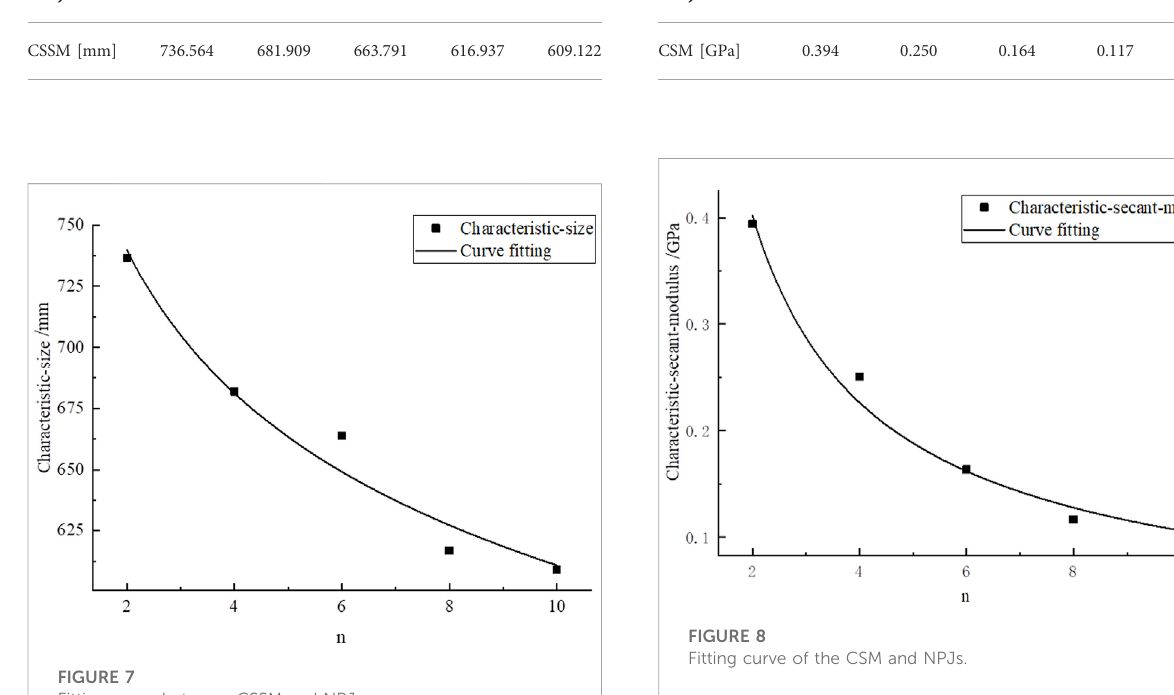
FIGURE 8 Fitting curve of the CSM and